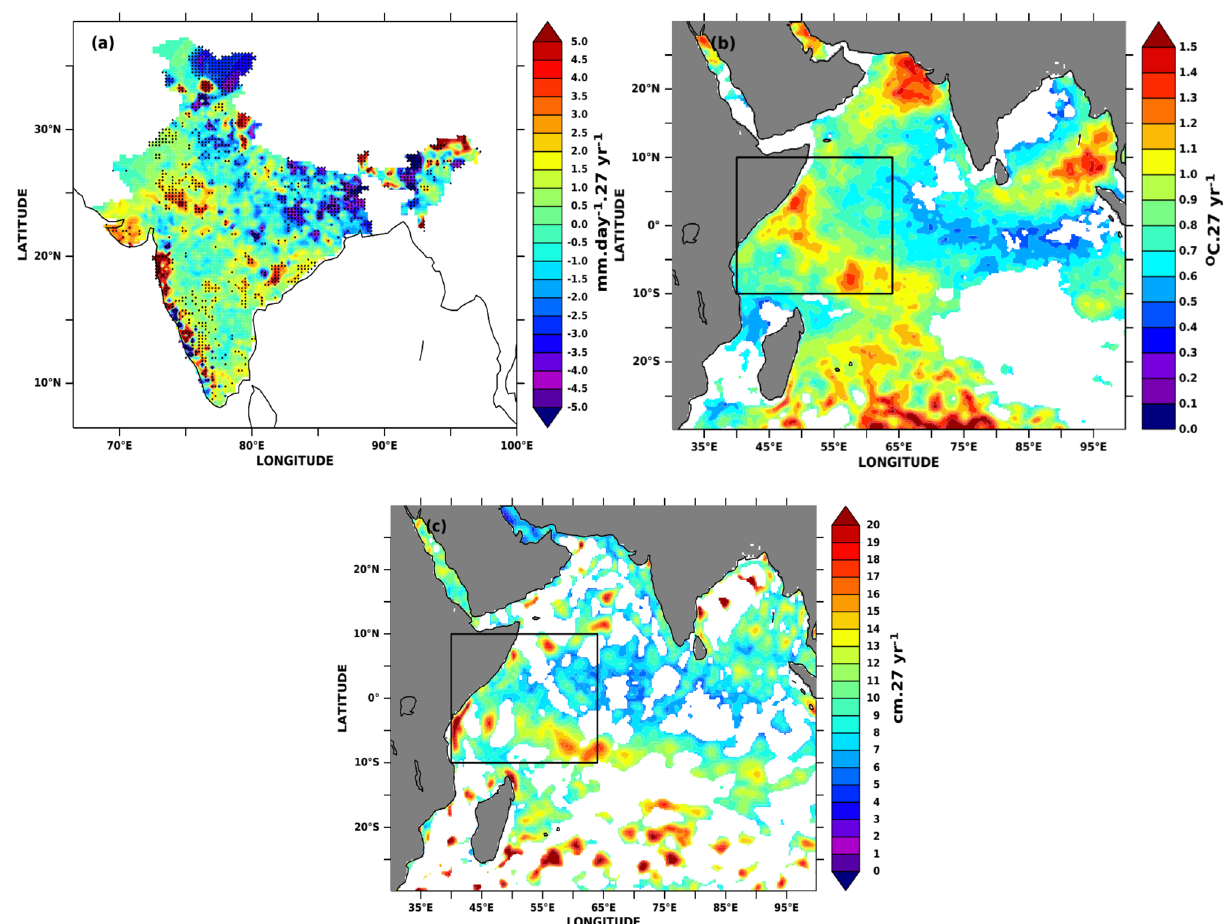
Figure 16. The linear trend for ( a ) AISMR, 90% significance trend is marked with black dots, ( b ) Apr–May SST, and ( c ) Apr–May SLA during 1993–2019. For both SST and SLA, areas with trends significant at 95% are plotted. The figure is generated using PyFerret